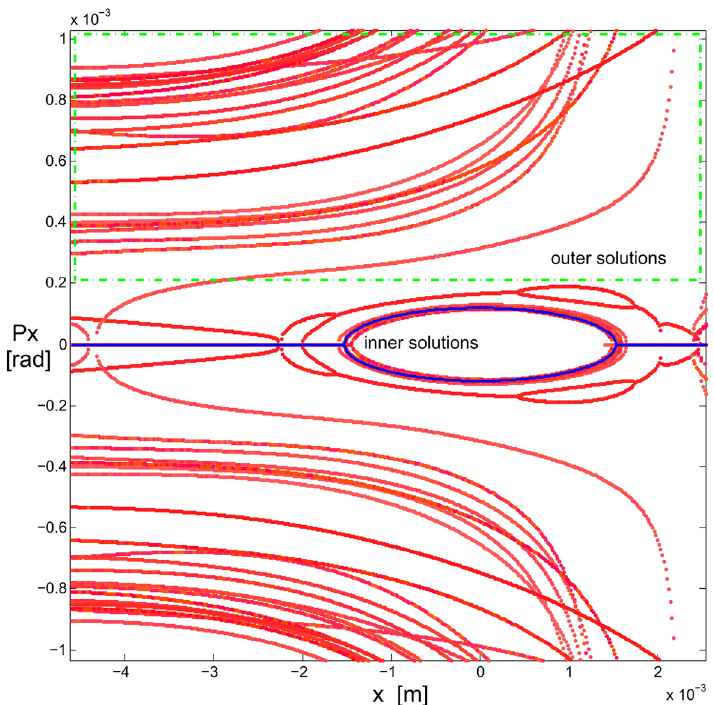
Figure 5. Phase space ( x , p x ) showing the evolution of the two real solutions (in red), under the optimization process of the objective function (when { S } values change). The ellipse, corresponding to the Courant-Snyder invariant of the linear problem, is shown in blue for comparison; it is the optimization method goal. The horizontal blue lines for p x = 0 depict the real part of p x , while the imaginary part is not shown in the figure, i.e., p x is a purely imaginary number. The outer branches are located mainly in the green rectangle, and they correspond to several { S } values for the single invariant used in the optimization process of the second stage (section